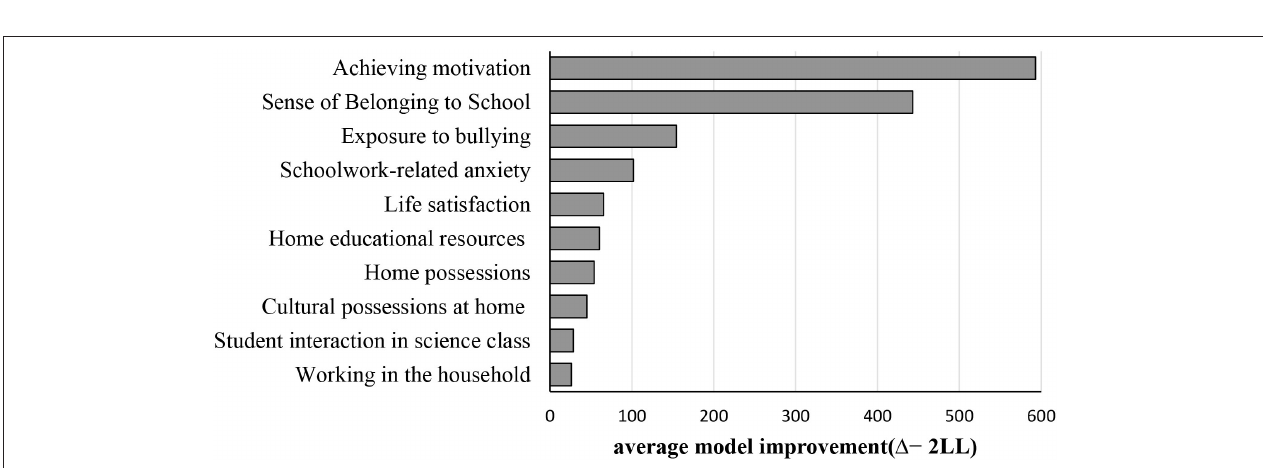
FIGURE 4 | Variable importance of demographic SEM Forest. The x-axis shows the average model improvement ( 1 two-group model splitting on a covariate. The length of the bar represented the variable importance of each covariable for the factor model, quantified as average increase in model misfit due to randomization.